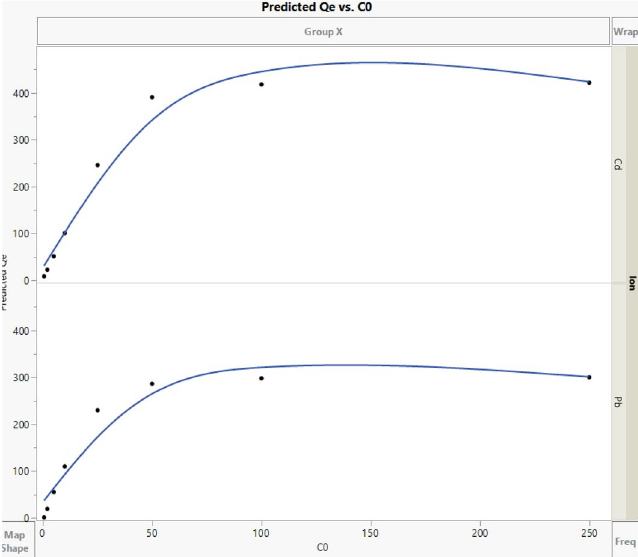
Figure 5. 2D plot of predicted